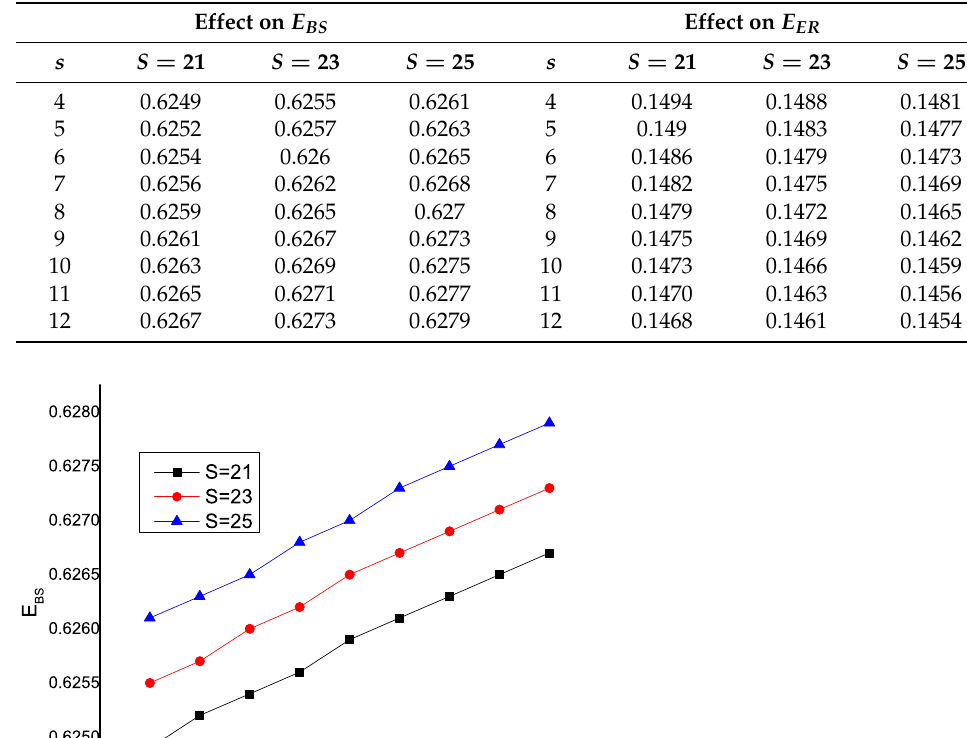
Table 7. Effect of s and S for ( c , δ , λ , µ , η ) = ( 3,0.8,4,7,2.6 ) .